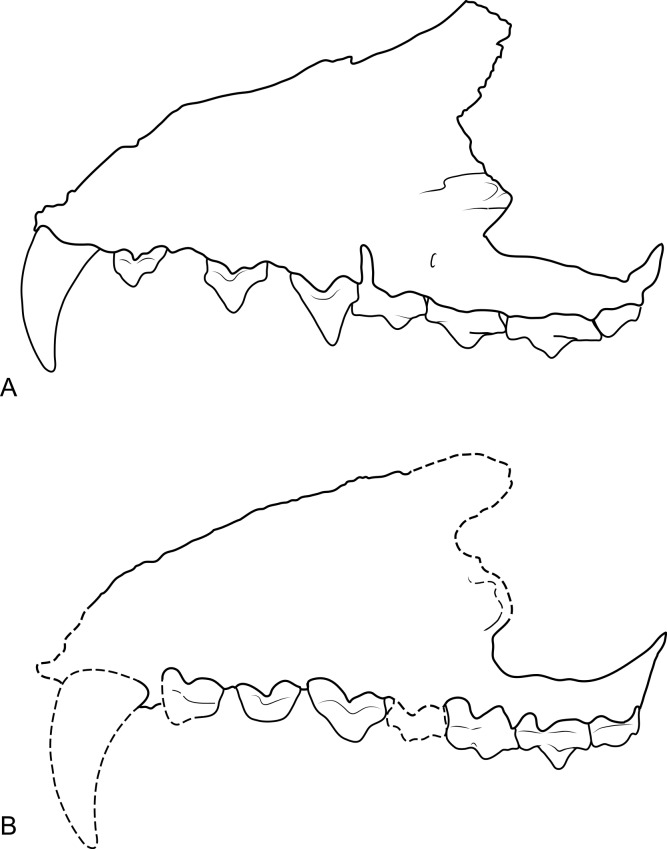
Comparison of Thylacinus maxillae.Comparison of the maxilla of Thylacinus cynocephalus and Th. potens. (A) left maxilla of Th. cynocephalus in lateral view, (B) right maxilla (reversed for comparison) of Th. potens in lateral view. Both drawings scaled to the same maxillary length for comparison. (A) redrawn from Murray & Megirian (2006, Appendix 1, Fig. 1), (B) based on NTM P4326.